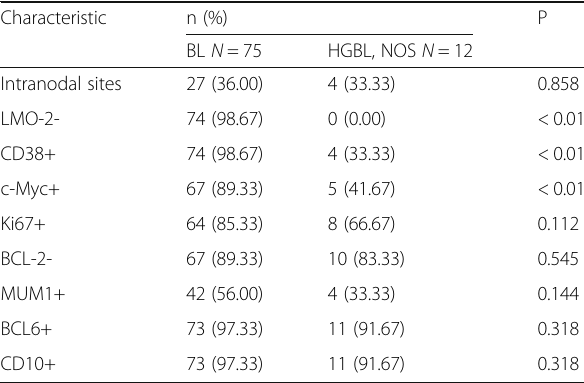
Table 2 The statistical analysis of immunohistochemical expression in Burkitt lymphoma and High-grade B-cell lymphoma, not otherwise specified